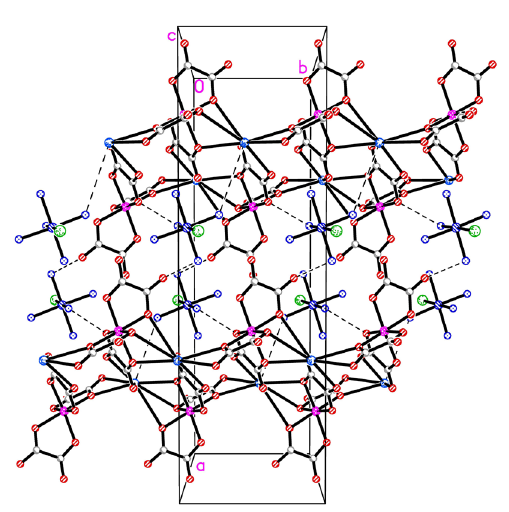
Figure 4. A sketch of the unit cell of complex 1. Atoms are colour- coded: potassium ions are larger blue spheres, cobalt ions are medium size blue spheres, chromium is displayed as pink spheres, and chloride ions are green. Carbon, nitrogen and oxygen atoms are displayed gray, small blue and red spheres, respectively. Hydrogen atoms are omitted for clarity.